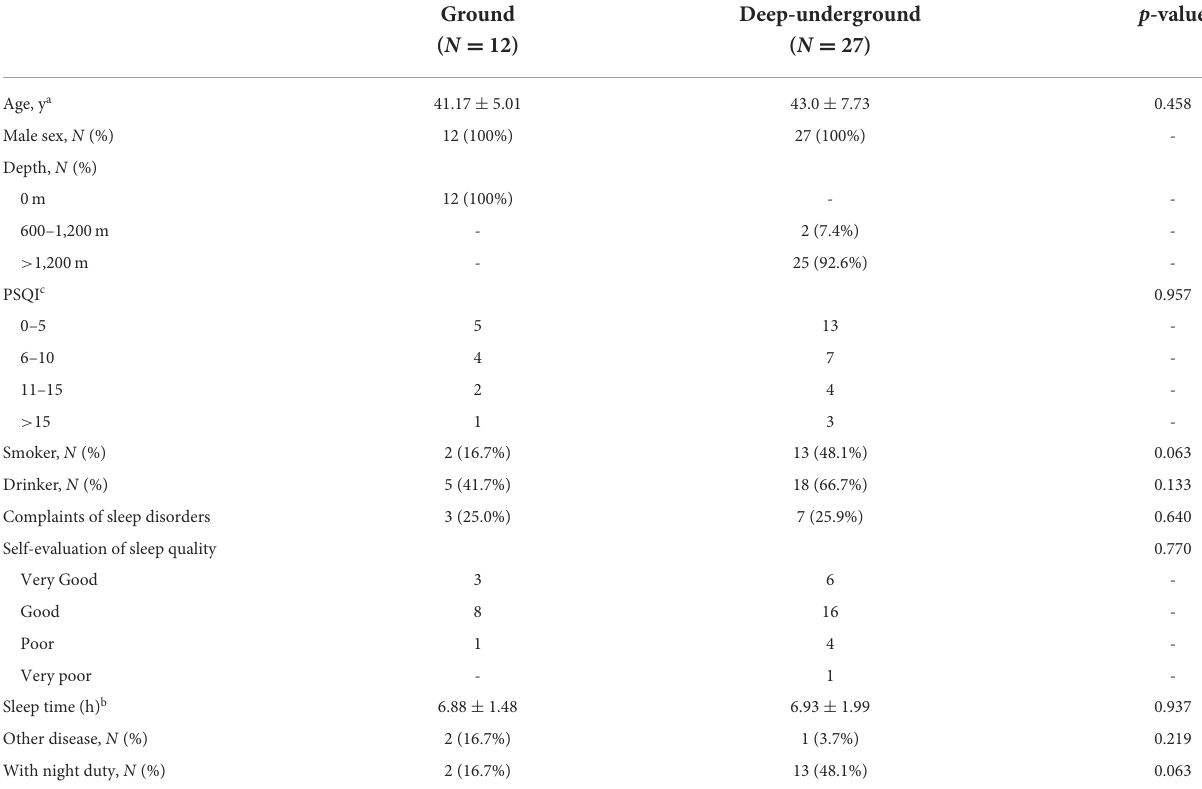
TABLE 1 Basic characteristics of